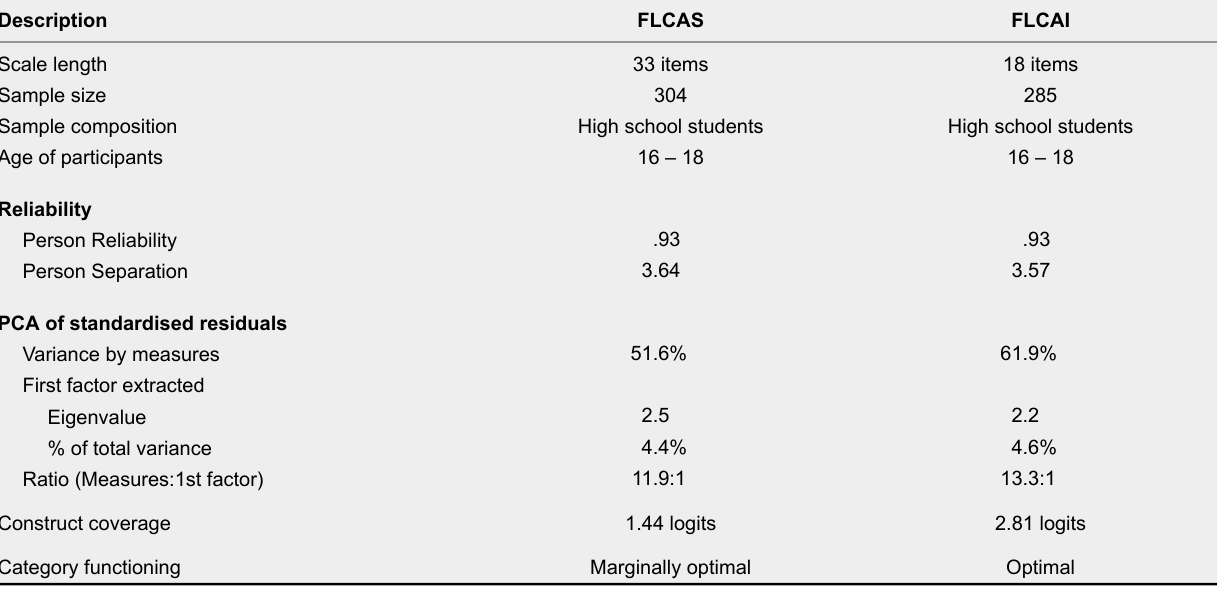
Comparisons between the FLCAI and